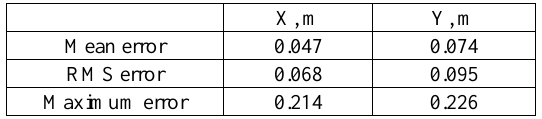
Table 5. Positional accuracy estimation of orthophoto plan points